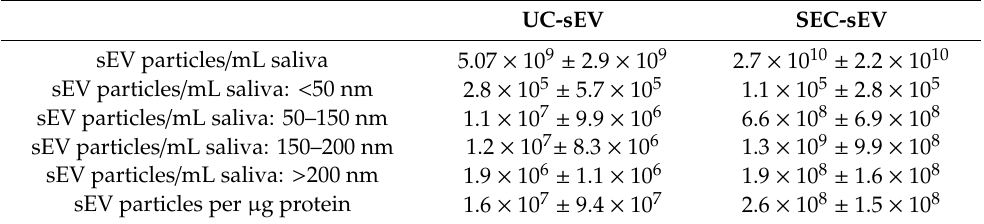
Table 2. Detailed Nanoparticle Tracking Analysis (NTA) information (mean ±